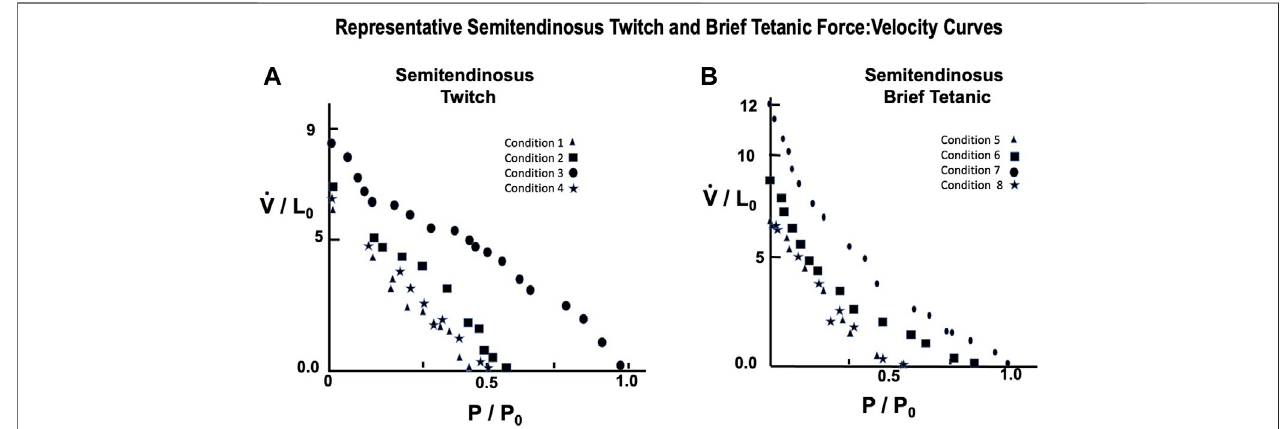
FIGURE 9 | Representative semitendinosus Force:Velocity measurements for twitch (A) and brief tetanic (B) stimulation. Each muscle was done under four different stimulus conditions, as described in the text. Conditions 3 and 7 represent the relationship at L i = L 0 and full stimulus intensity. The remaining conditions were used todeterminetheeffect oflengthand/or activationsonthisrelationship. Conditions1and5weredoneat L i =L 0 ,reducedstimulusvoltage, Conditions2and6were done at L i < L 0 , reduced stimulus voltage, and Conditions 4 and 8 were done at L i < L 0 , full stimulus voltage.